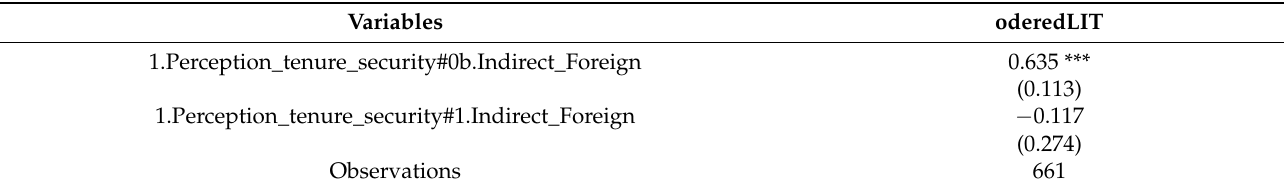
Table 9. Effect of indirect exposure to LSLA by foreign entities through tenure security.